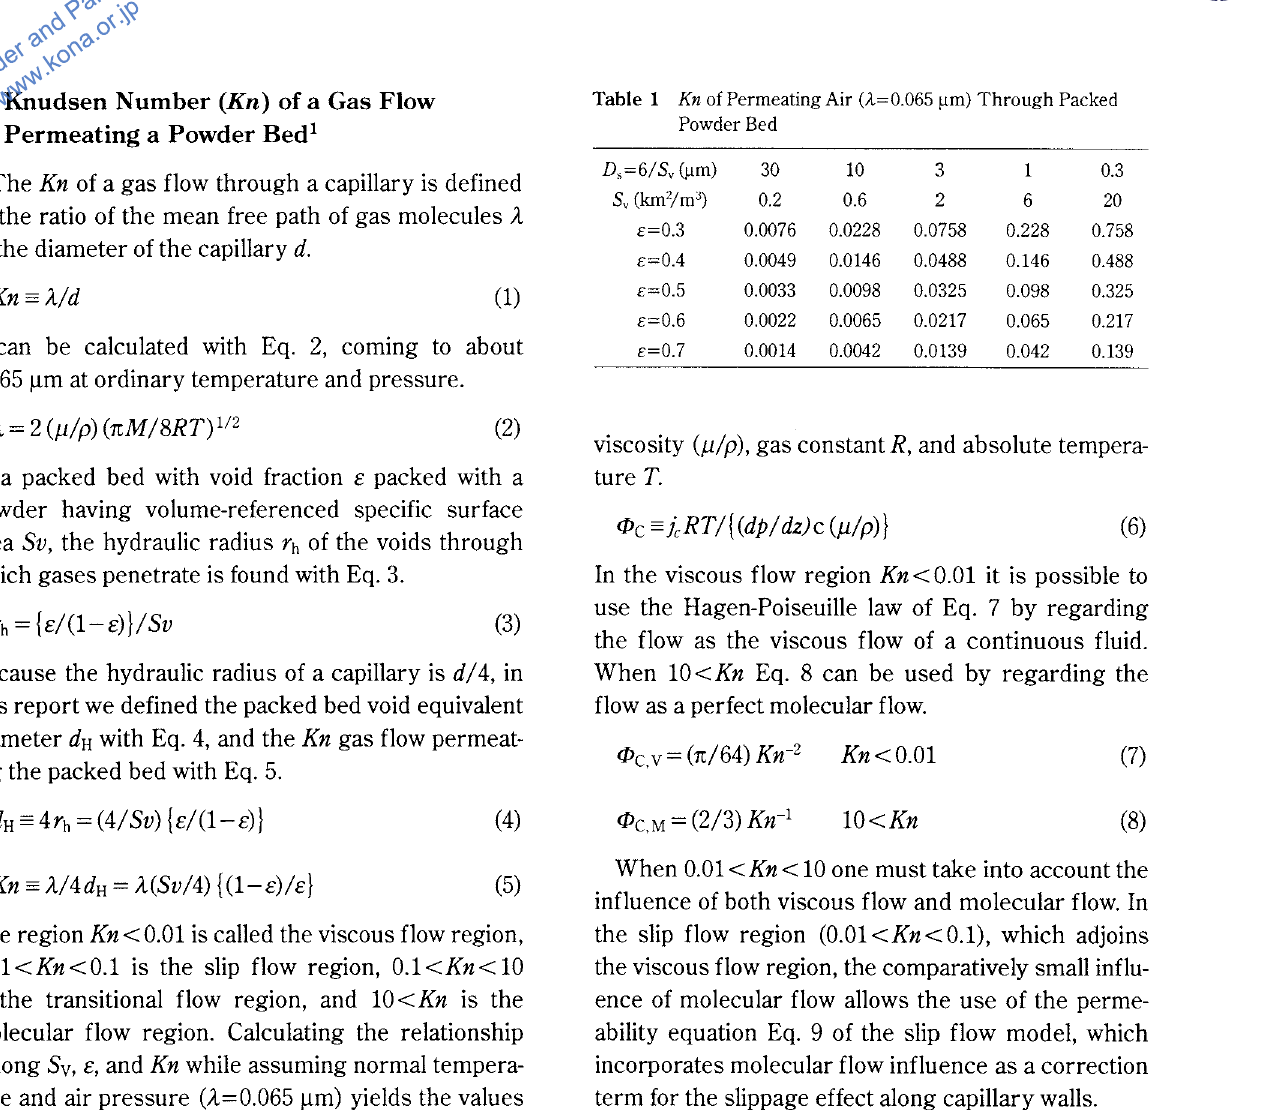
Table 1 Kn of Permeating Air (Jc=0.065 J.lffi) Through Packed Powder Bed D,=6/Sv